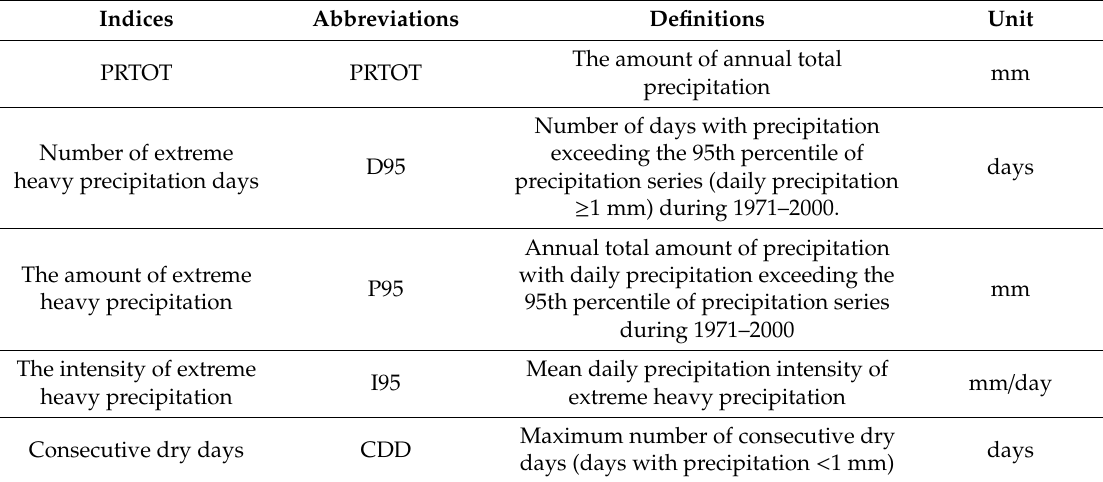
Table 1. Definitions of five precipitation indices that were used in the